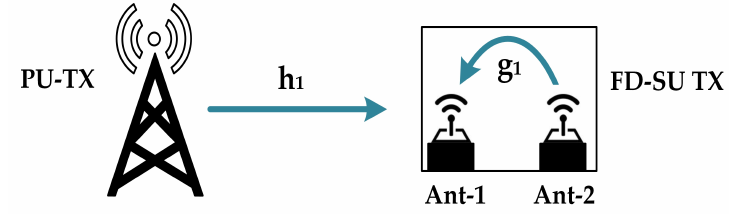
Figure 2. Network model with PU and full duplex-enabled secondary user transmitter (FD-SU TX).